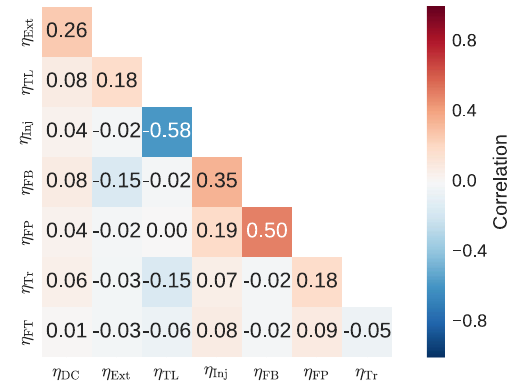
FIG. 21. Correlation heat map for the figures of merit used in the analysis of CT